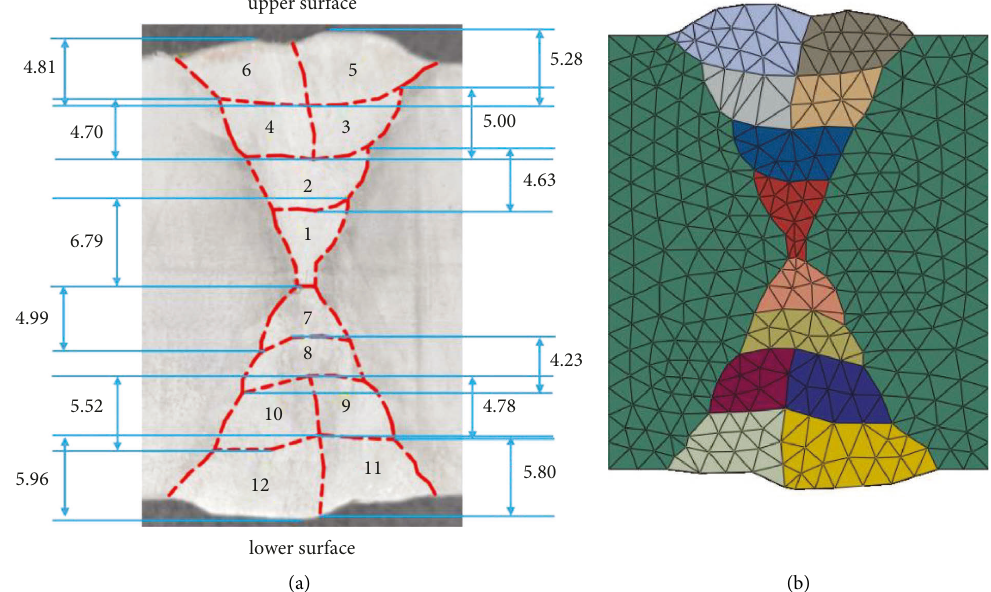
Figure 13: The schematic diagram of each weld layer and welding bead (unit: mm). (a) Actual profile of each weld bead. (b) Profile of each weld bead in the FE model.